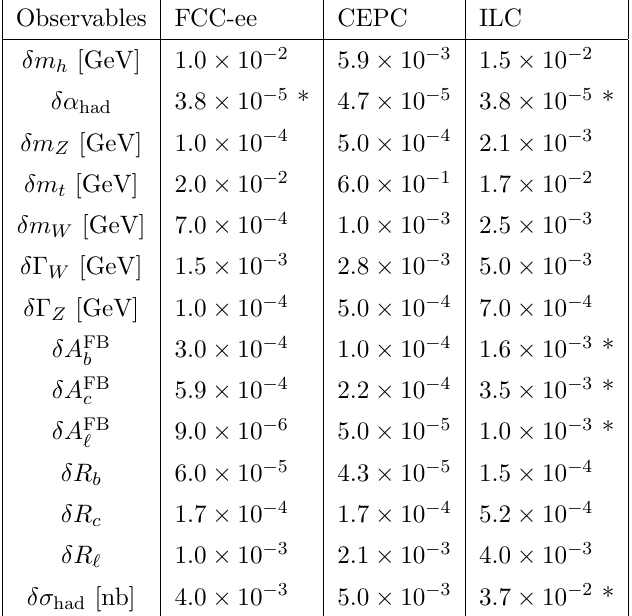
Table 1 . The observables and corresponding precision used in S=T=U (cid:12)tting for each future collider. Most of the values [40] come from the corresponding CDRs of Fcc-ee [41, 42], CEPC [27], and ILC [33], except for the values with *, which comes from earlier studies [35, 43, 44]. For ILC we choose its Giga-Z